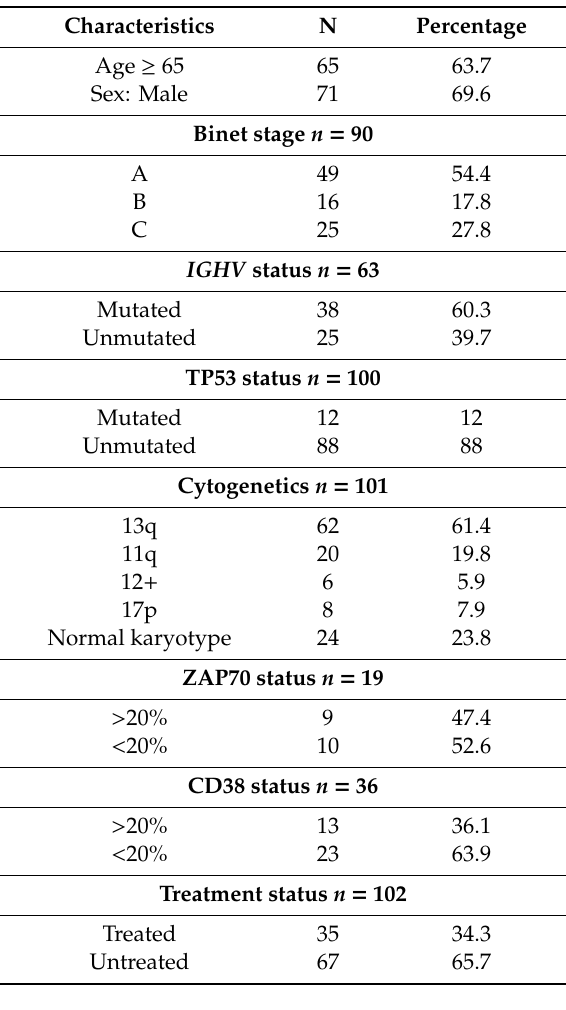
Table 1. Clinical and molecular characteristics of the CLL cohort used in this study.